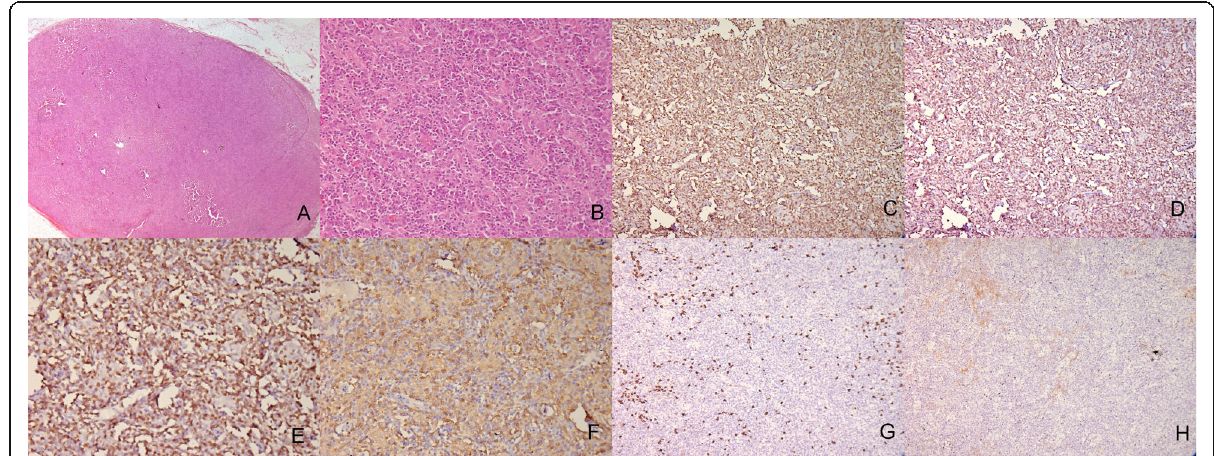
Fig. 2 Lymph node biopsy shows effacement